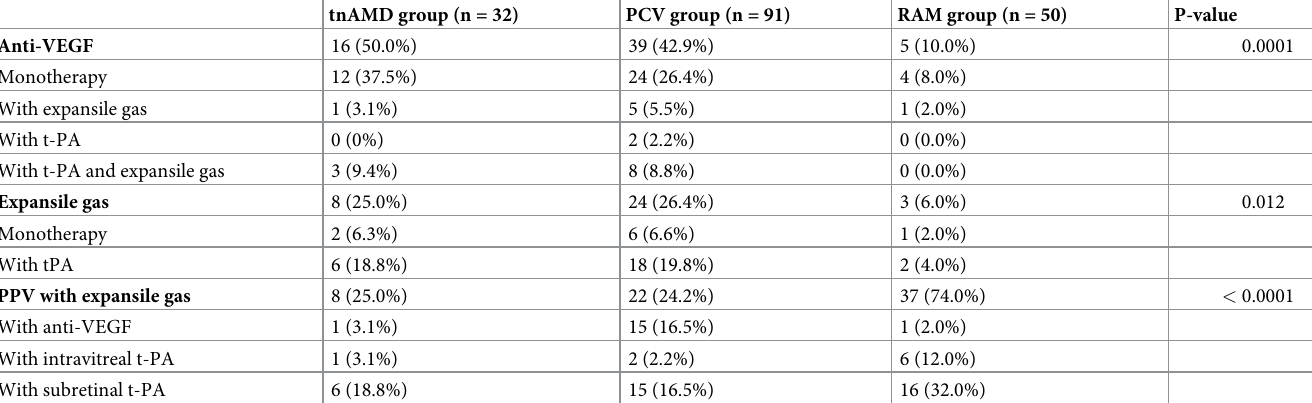
Table 2. Initially selected treatments in eyes with SMH in tnAMD, PCV and RAM groups.